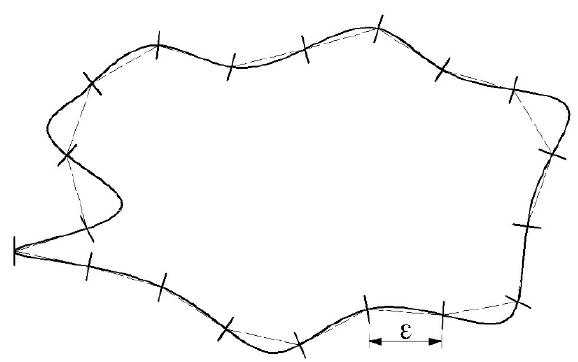
Figure 8. Schematic diagram of the D pr algorithm.